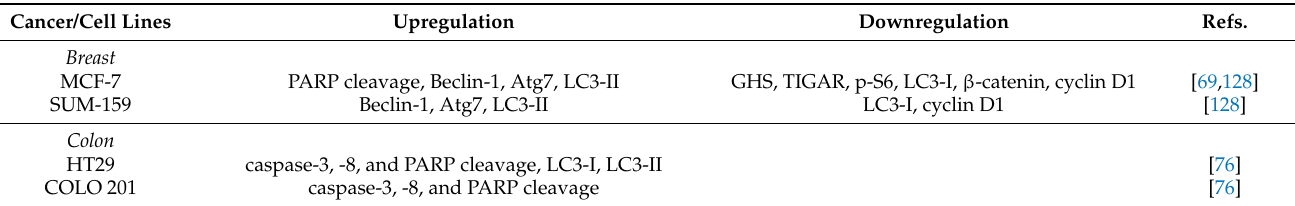
Table 2. Molecular targets of resveratrol-induced